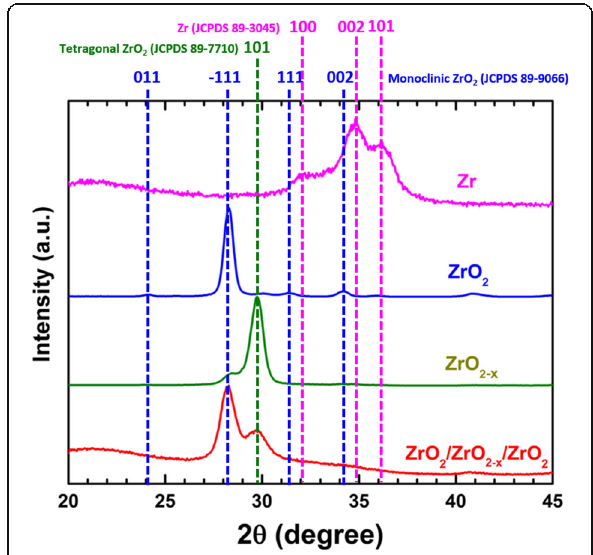
Fig. 1 XRD patterns of the as-deposited ZrO 2 /ZrO 2 − x /ZrO 2 tri-layer structure ( red ), oxygen-deficient ZrO 2- x layer ( green ), stoichiometric ZrO 2 layer ( blue ) and pure metallic Zr layer ( pink )